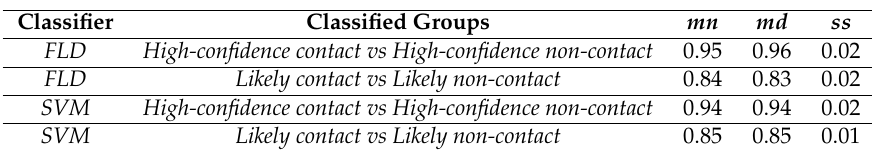
Table 2. Results of FLD and SVM classifiers in terms of AUC, where mn , md , and sd denote the mean, median, and standard deviation through all the cross-validation